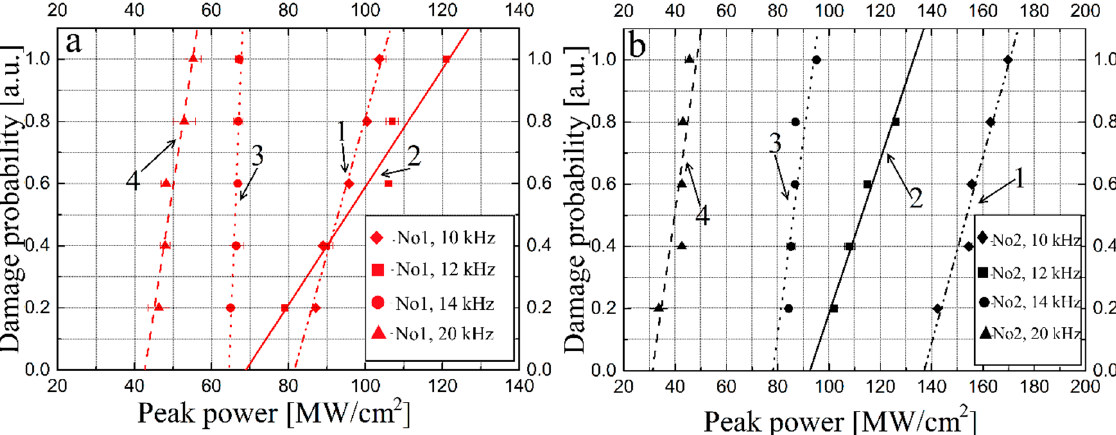
Figure 7. ( a ) Dependences of the sample no. 1 (GaSe) damage probability on the damage peak power (exposure time—1 s): 1—at a pulse repetition rate of 10 kHz; 2—at a pulse repetition rate of 12 kHz; 3—at a pulse repetition rate of 14 kHz; 4—at a pulse repetition rate of 20 kHz. ( b ) Dependences of the sample no. 2 (GaSe:In) damage probability on the damage peak power (exposure time—1 s): 1—at a pulse repetition rate of 10 kHz; 2—at a pulse repetition rate of 12 kHz; 3—at a pulse repetition rate of 14 kHz; 4—at a pulse repetition rate of 20 kHz. Table 2. Laser-induced damage threshold (LIDT) results for GaSe: the values of fluence 𝑊 (cid:2868)(cid:3031)(cid:3006) and peak power 𝑊 (cid:2868)(cid:3031)(cid:3017) with LIDT probability equal to 0, the values of fluence 𝑊 (cid:2869)(cid:3031)(cid:3006) and peak power 𝑊 (cid:2869)(cid:3031)(cid:3043) with LIDT probability equal to 1, the average value of fluence 𝑊 (cid:3005)(cid:3006) and peak power 𝑊 (cid:3005)(cid:3017) taking into account the measurement error; Student’s coefficient k at confi- dence probability—0.95, standard deviation— √s (cid:2870) , number of measurements—N. Sample